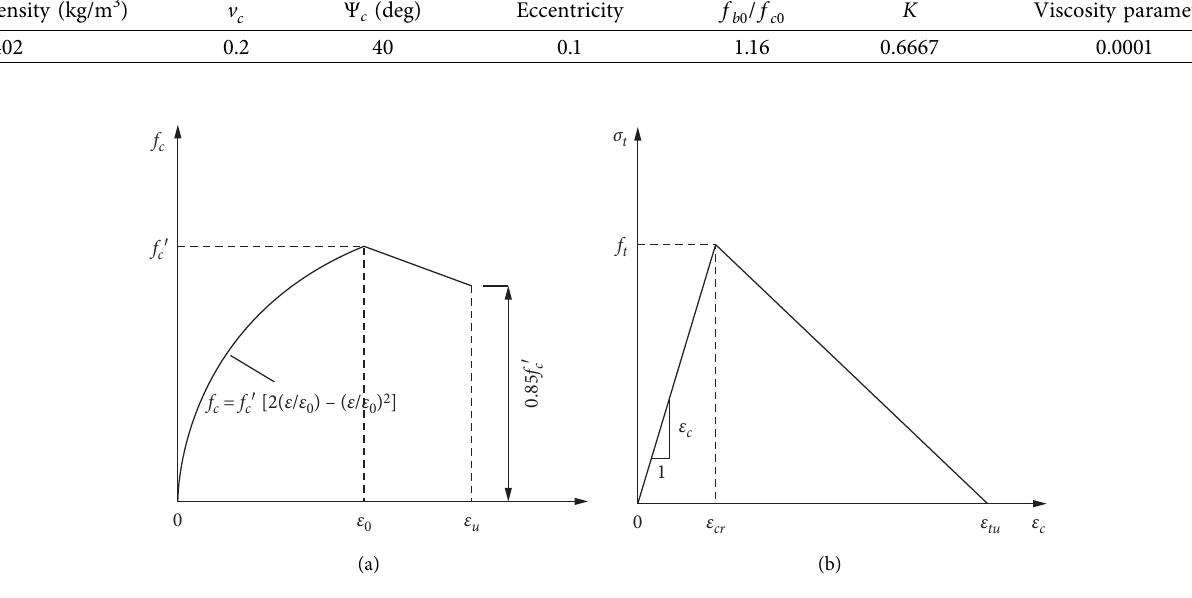
Figure 6: Concrete stress-strain diagram. (a) Under compression. (b) Under tension.